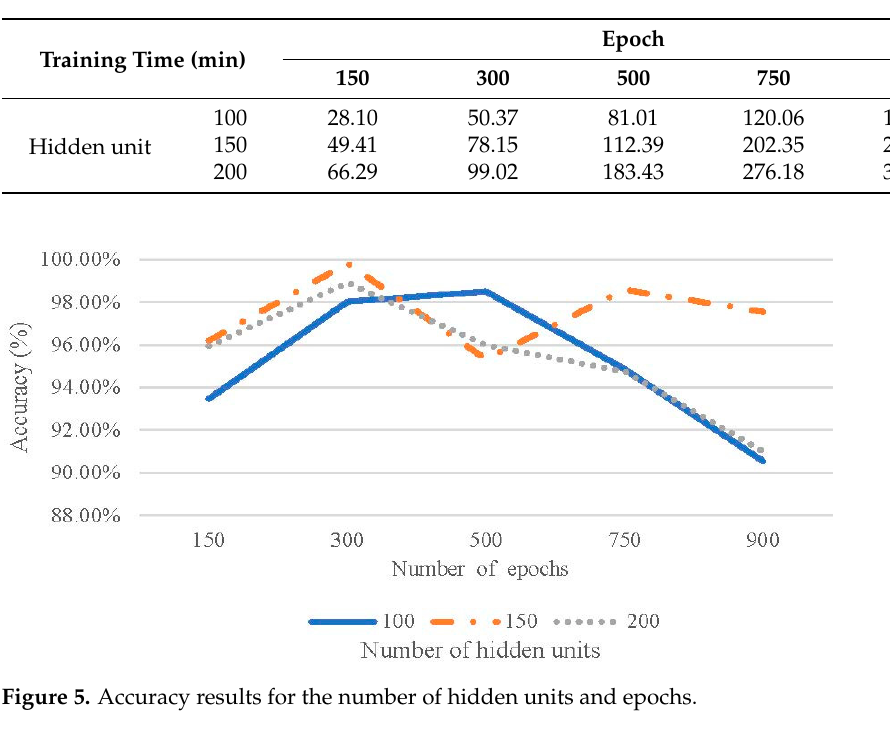
Figure 5. Accuracy results for the number of hidden units and epochs.